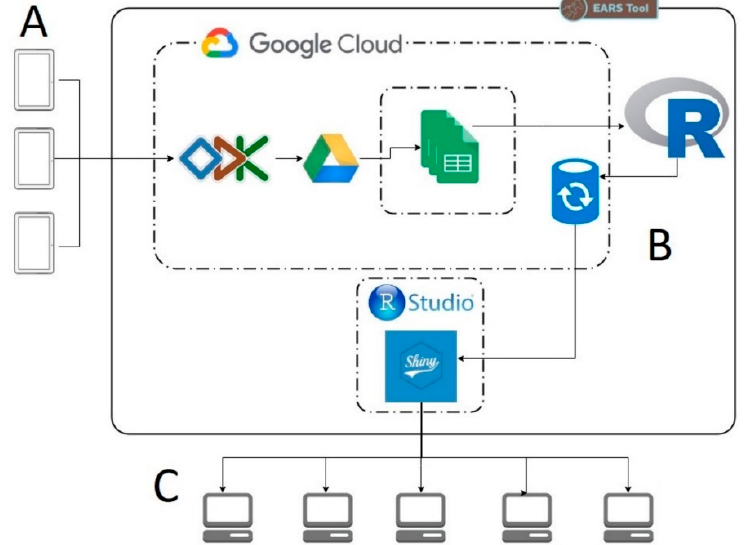
Figure 1. EARS data workflow with ( A ) representing data collection on an android device, ( B ) representing the cloud-based data storage and manipulation and ( C ) being the end-user interacting with a dashboard. Table 3. Hardware and software requirements for the different data workflow stages within the EARS tool.